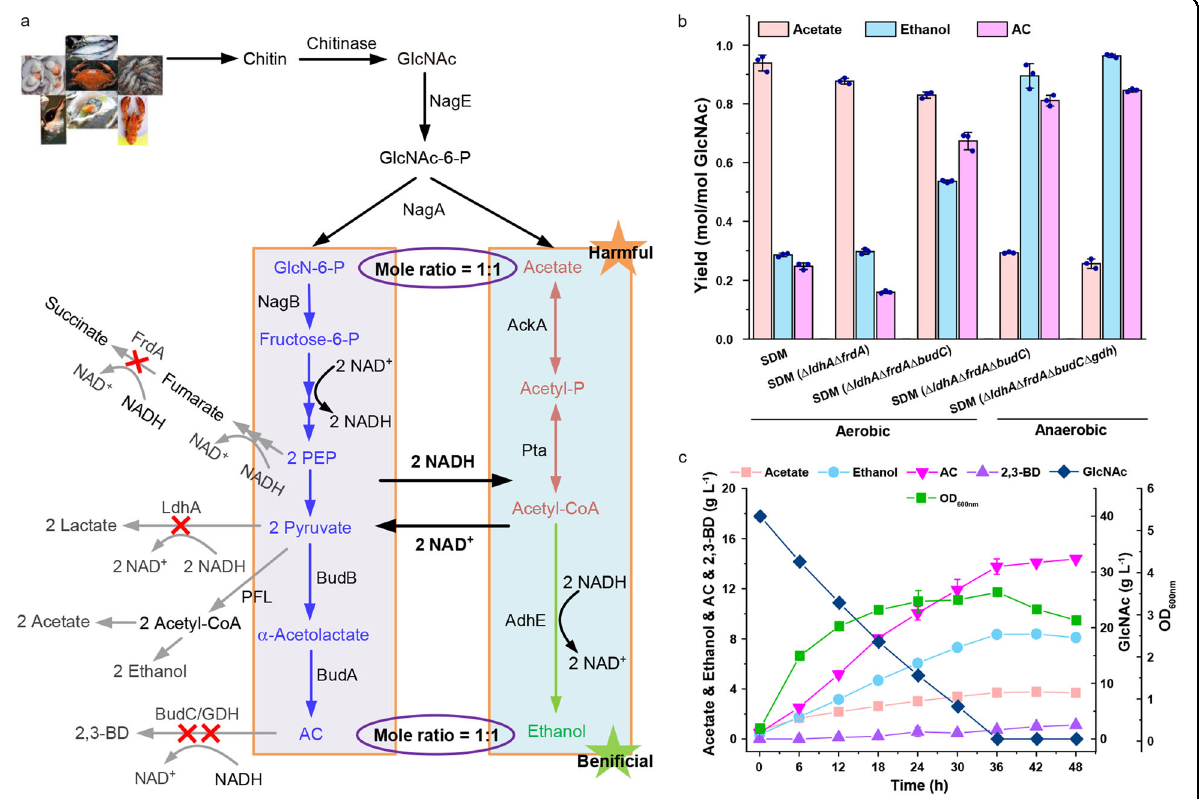
Fig. 5 Production of AC and ethanol from chitin based on the acetate elimination mechanism in E. cloacae SDM. a Schematic diagram of chitin enzymolysis and GlcNAc metabolism in E. cloacae SDM ( Δ ldhA Δ frdA Δ budC Δ gdh ). NagE, N-acetylglucosamine speci fi c PTS enzyme IIABC component; NagA, N-acetylglucosamine-6-phosphate deacetylase; NagB, glucosamine-6-phosphate deaminase; FrdA, fumarate reductase; LdhA, lactate dehydrogenase; PFL, pyruvate formate lyase; BudB, α -acetolactate synthase; BudA, α -acetolactate decarboxylase; BudC/GDH, 2,3-butanediol dehydrogenase; AckA, acetate kinase; Pta, phosphate acetyltransferase; AdhE, bifunctional acetaldehyde/ethanol dehydrogenase. b Yield of acetate, ethanol and AC produced by E. cloacae SDM and its derivatives under aerobic or anaerobic conditions using GlcNAc as the carbon source. c Batch fermentation using chitin hydrolysate as carbon source by E. cloacae SDM ( Δ ldhA Δ frdA Δ budC Δ gdh ) under anaerobic conditions. Data shown are means ± SD ( n = 3 independent